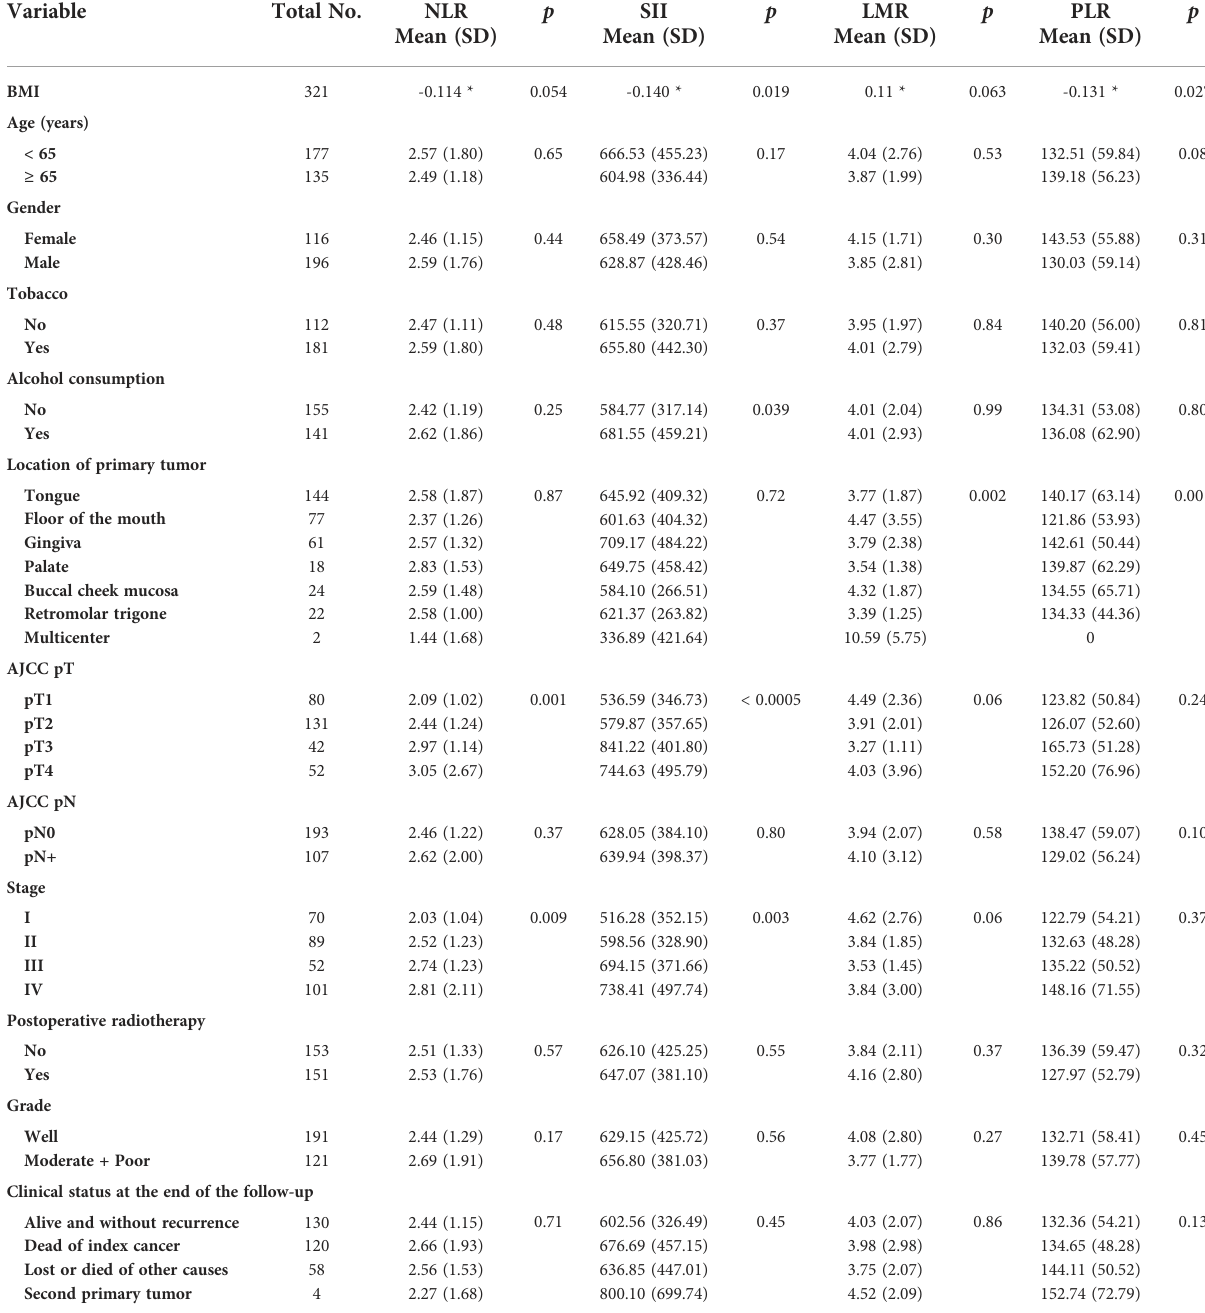
TABLE 3 Relationships between the clinicopathological variables and in fl ammatory ratios calculated for the cohort of 348 OSCC patients. Variable Total